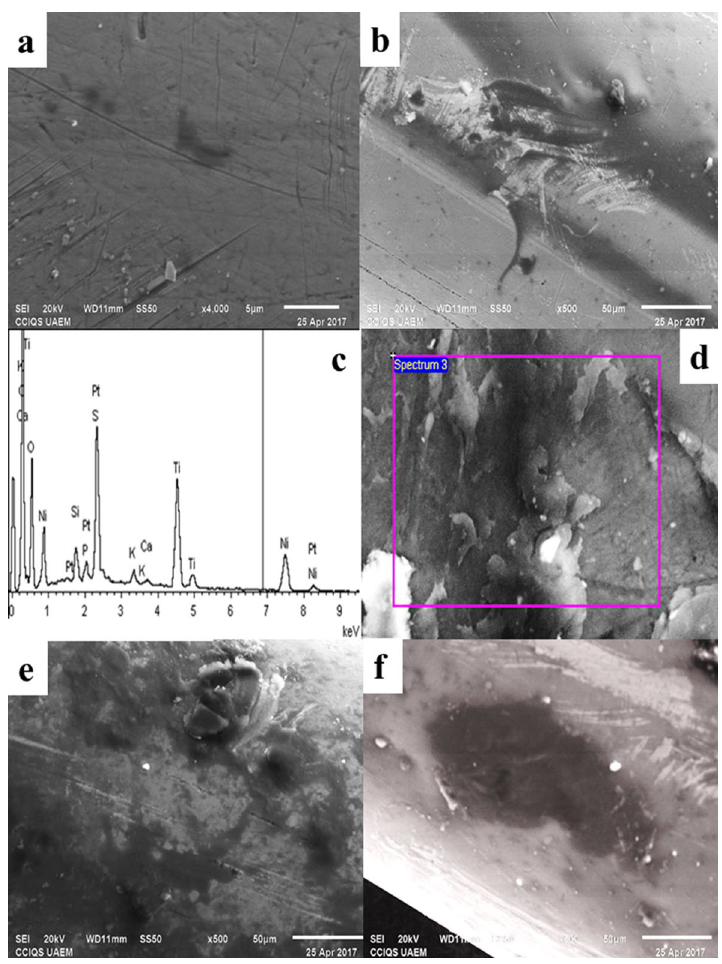
Figure 3. The 0.016 ″ Ni–Ti arch analyzed using SEM. ( A ) Reference sample surface arc, increase ×4000. ( B ) Surface RCO after 1 month cabbage or cation in oral cavity. ( C ) EDS of the arch after 1 month of placement. ( D ) Arc surface after 1 month of placement, at higher magnification. ( E ) The arc surface is observed with the presence of corrosion zones. ( F ) Corrosion surface, increase of